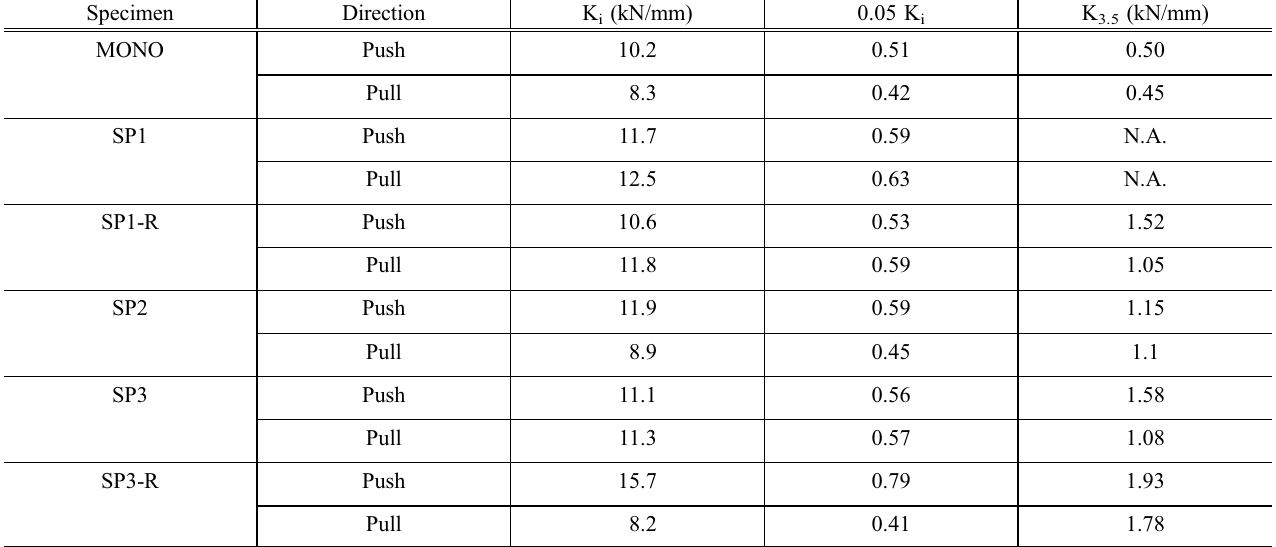
Table 5 Initial stiffnesses of test specimens.